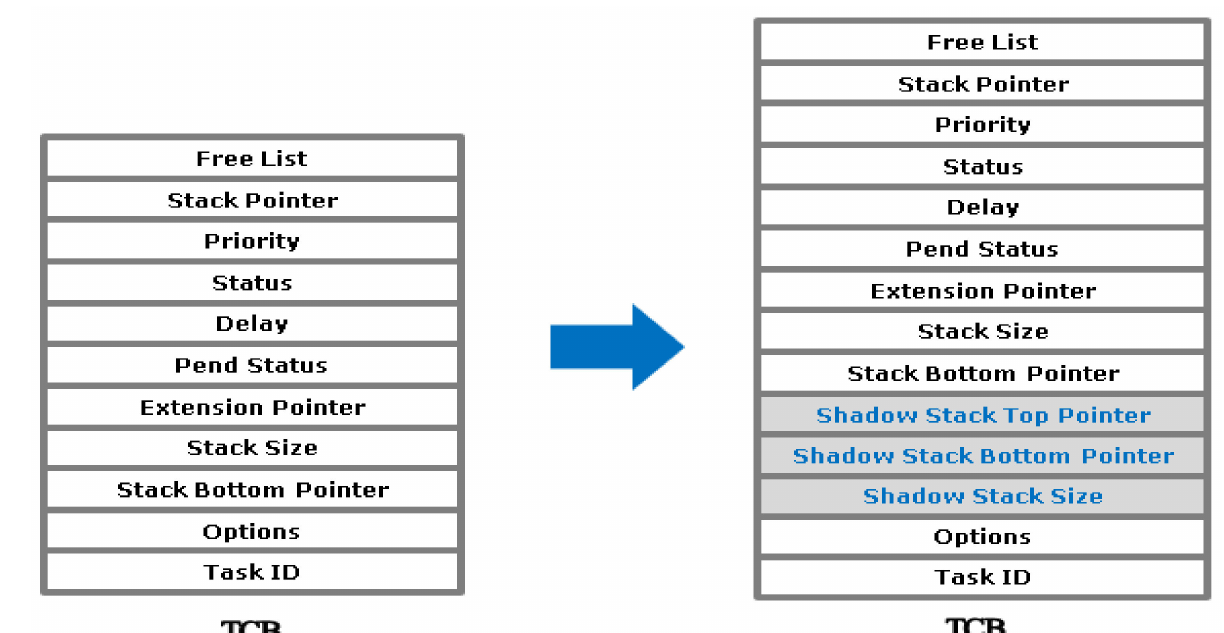
Figure 3. Task Control Block (TCB) with shadow stack information.